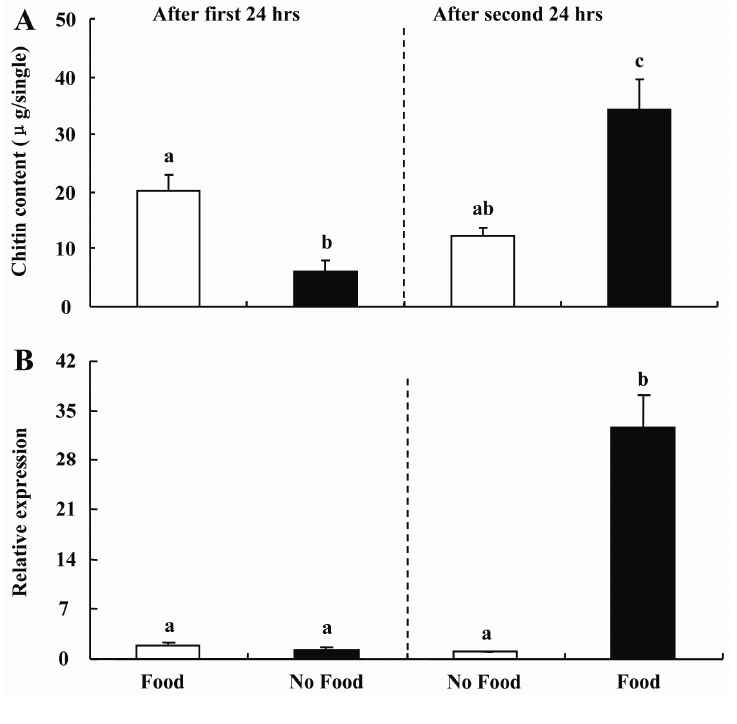
Figure 5. ( A ) Changes of chitin content and ( B ) mRNA levels of BdCHS2 in the midgut of third instar larvae of Bactrocera dorsalis under food or no food conditions. Larvae in set 1 (empty bars) were fed for 24 h and then maintained with no food for the next 24 h, whereas larvae in set 2 (black bars) were maintained with no food for 24 h and then fed for the next 24 h. α -Tubulin was used as an internal reference gene. Data are means ± SE of four biological replications, each with two technical replications. Different letters above each bar indicate statistically significant difference by ANOVA followed by the Duncan’s multiple range test ( p <